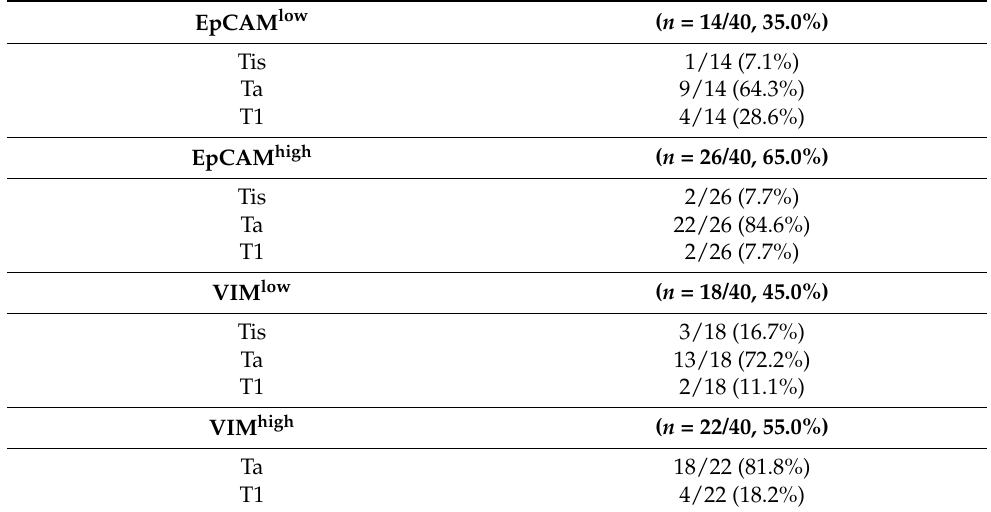
Table 4. Correlation between EpCAM or VIM expression levels in blood CTCs and pathological stage T in NMIBC